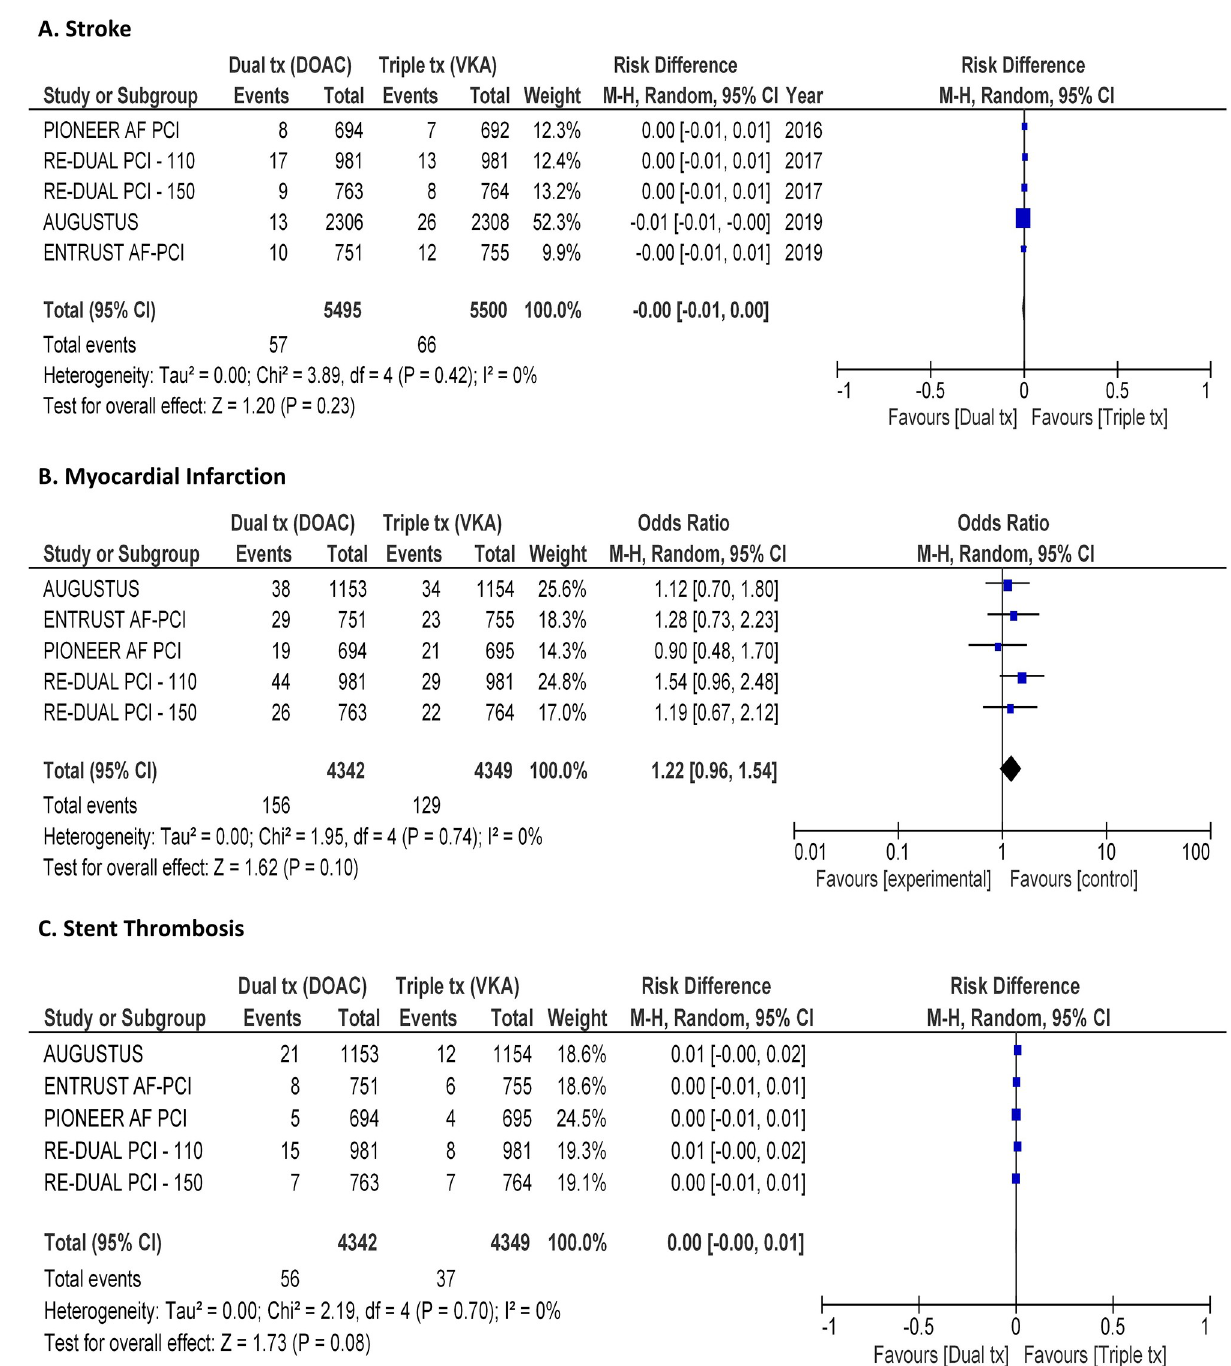
Fig 3. Forest plots illustrating the results of meta-analysis on the rate of stroke (panel A), myocardial infarction (panel B) and stent thrombosis (panel C). 95% C.I. = 95% confidence interval; DOAC = direct oral anticoagulants; VKA = vitamin K antagonist; I 2 = Inconsistency index. https://doi.org/10.1371/journal.pone.0235511.g003 compared a DAT regimen including a DOAC versus a TAT regimen including a VKA (repre- senting the previous clinical standard). On the contrary, we maintained the same between-the- groups comparison across all included studies and could not find any significant difference in Stent Thrombosis rate among. Nevertheless, it should be remembered that the risk for Stent